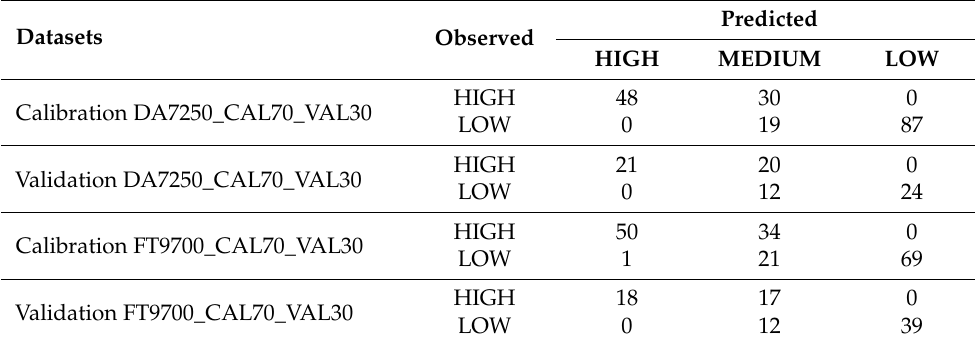
Table 5. Level of misclassification of observed protein concentration (High and Low groups) after predicted with the final models for both DA7250 and FT9700